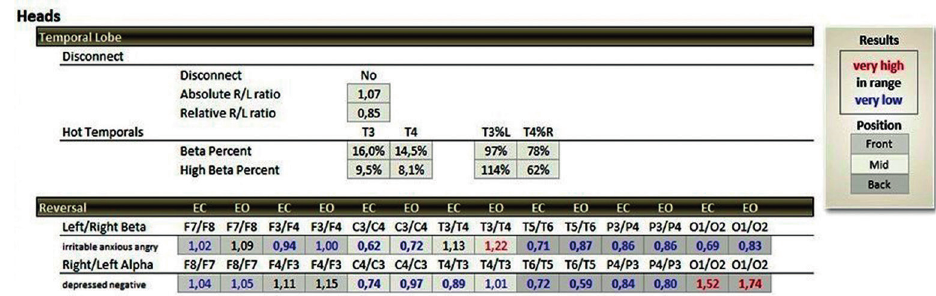
Figure 2. The expected percentage of Beta-wave (15-23 Hz) and Beta-High (23-38 Hz) waves at the T3 and T4 points of the 10-20 electroencephalography system in a broad statistical distribution (TQ-7 heads page), expressed in black color, representing the control